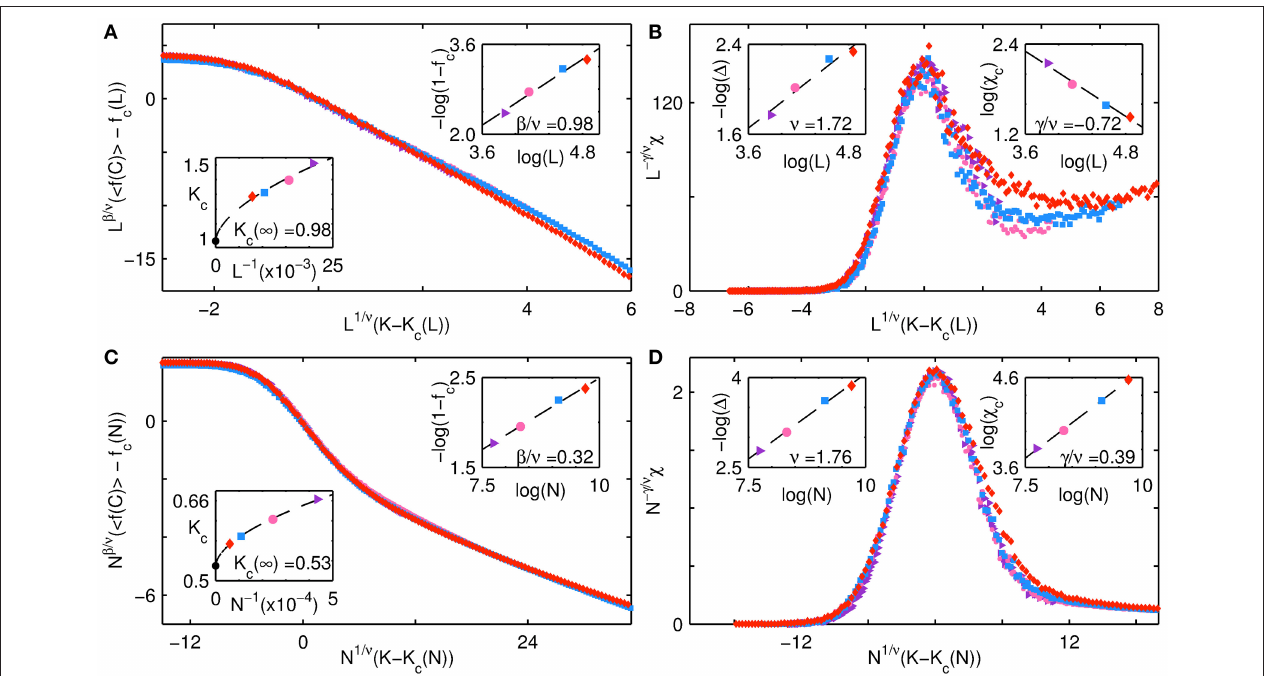
FIGURE 6 | Collective behavior of a network of agents at the interface of the fluctuating and all C regimes for different system sizes. Finite-size scaling results are f ( C ) shown for the cases (A,B) p 0, b 0.96, and (C,D) p 1, b 1.05. (A,C) show the order parameter, viz., mean fraction of cooperators (averaged over 10 3 = = = = h i trials), while (B,D) show the corresponding dependence of the susceptibility χ (obtained from Equation (2) using values of f ( C ) obtained over 10 3 trials) on K . The abscissae of each of the panels represents the deviation of the noise K from the critical noise value K c ( N ), scaled by N 1 /ν . The ordinate for (A,C) shows the deviation of the order parameter from its value f c ( N ) at the critical point K c ( N ), scaled by N β/ν , while the ordinate for (B,D) shows the susceptibility scaled by N γ/ν . The curves are seen to collapse upon using exponent values obtained from finite-size scaling, viz., (A,B) ν 1.72 0.25, β/ν 0.98 0.10, γ/ν 0.72 0.06 and (C,D) = ± = ± = − ± f c ) to log ( N ), while the insets ν 1.76 0.09, β/ν 0.32 0.02, γ/ν 0.39 0.01. The insets in (A,C) show the least-square fits of Equation (3) to K c and log (1 = ± = ± = ± − in (B,D) show the least-square fits of log ( 1 c ) to log ( N ) and log ( χ c ) to log ( N ). Different symbols are used to indicate the different system sizes N for which the simulations were carried out, namely, a purple triangle ( N 48 2 ), a pink circle ( N 64 2 ), a blue square ( N 96 2 ) and a red diamond ( N 128 2 ). Note that for the = = = = case p 0, i.e., (A,B) , the scaling is in terms of L rather than N =